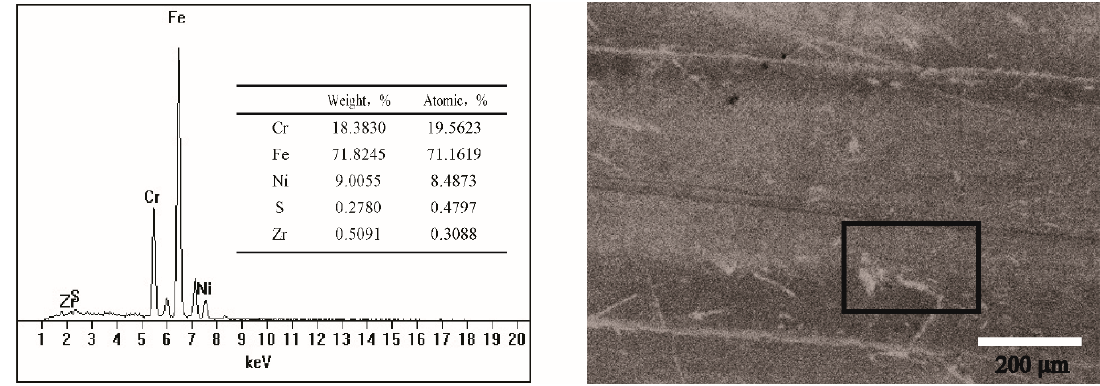
Figure 9. EDS of the wear scar lubricated by the base oil with lamellar ZrS 2 nanobelt additives.